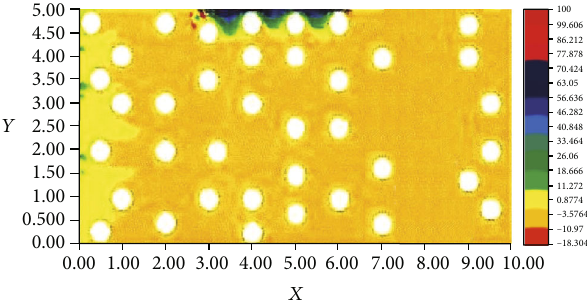
Figure 18: Concentrations, D = 0 : 001 , C